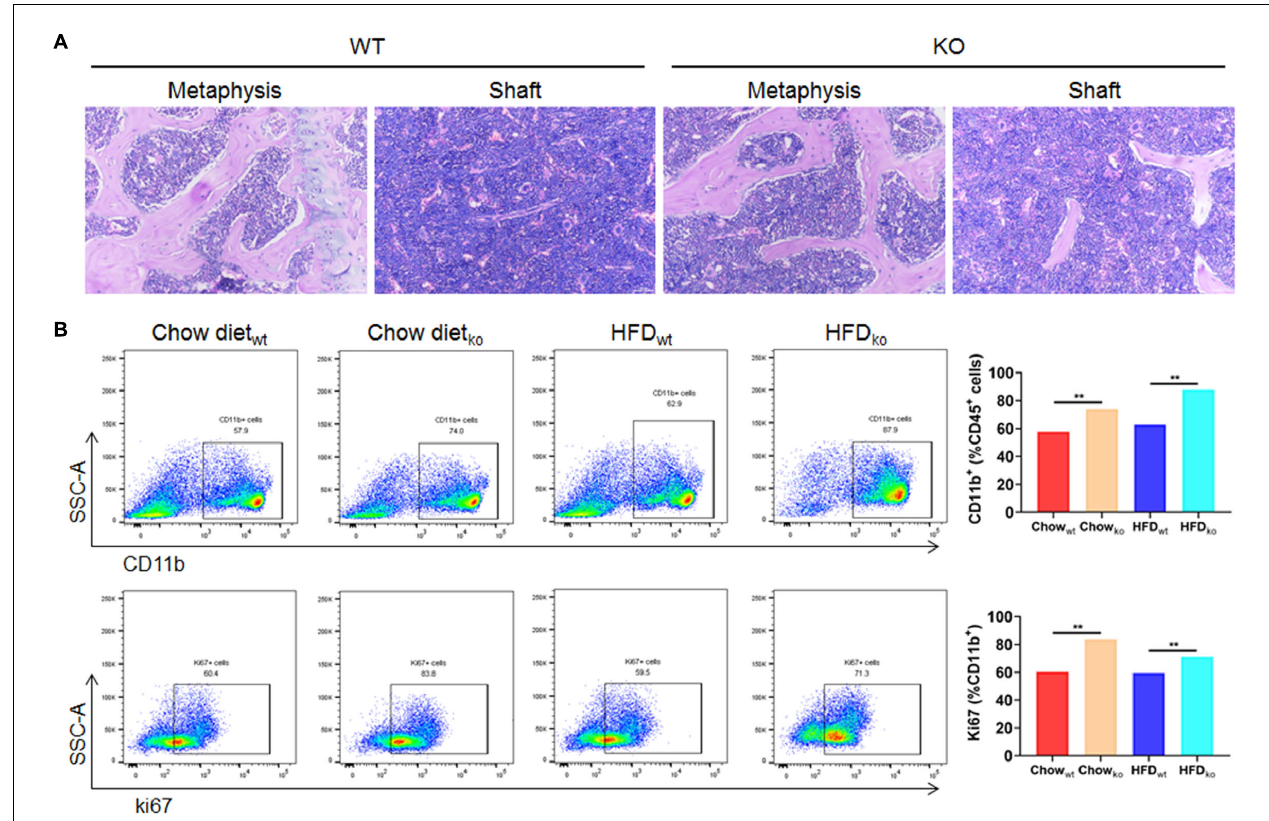
FIGURE 6 | The proliferation of cells from the bone marrow mononuclear phagocyte system is increased in LAMTOR1 MKO mice. (A) HE staining of the bone marrow. (B) Flow cytometry analysis of bone marrow cells. The results refer to the bone marrow of the left femurs since both left and right femoral bone marrow displayed the same results. n = 4. ** P < 0.01 vs. WT. HFD, high-fat diet; KO, myeloid-specific knockout mice; WT,